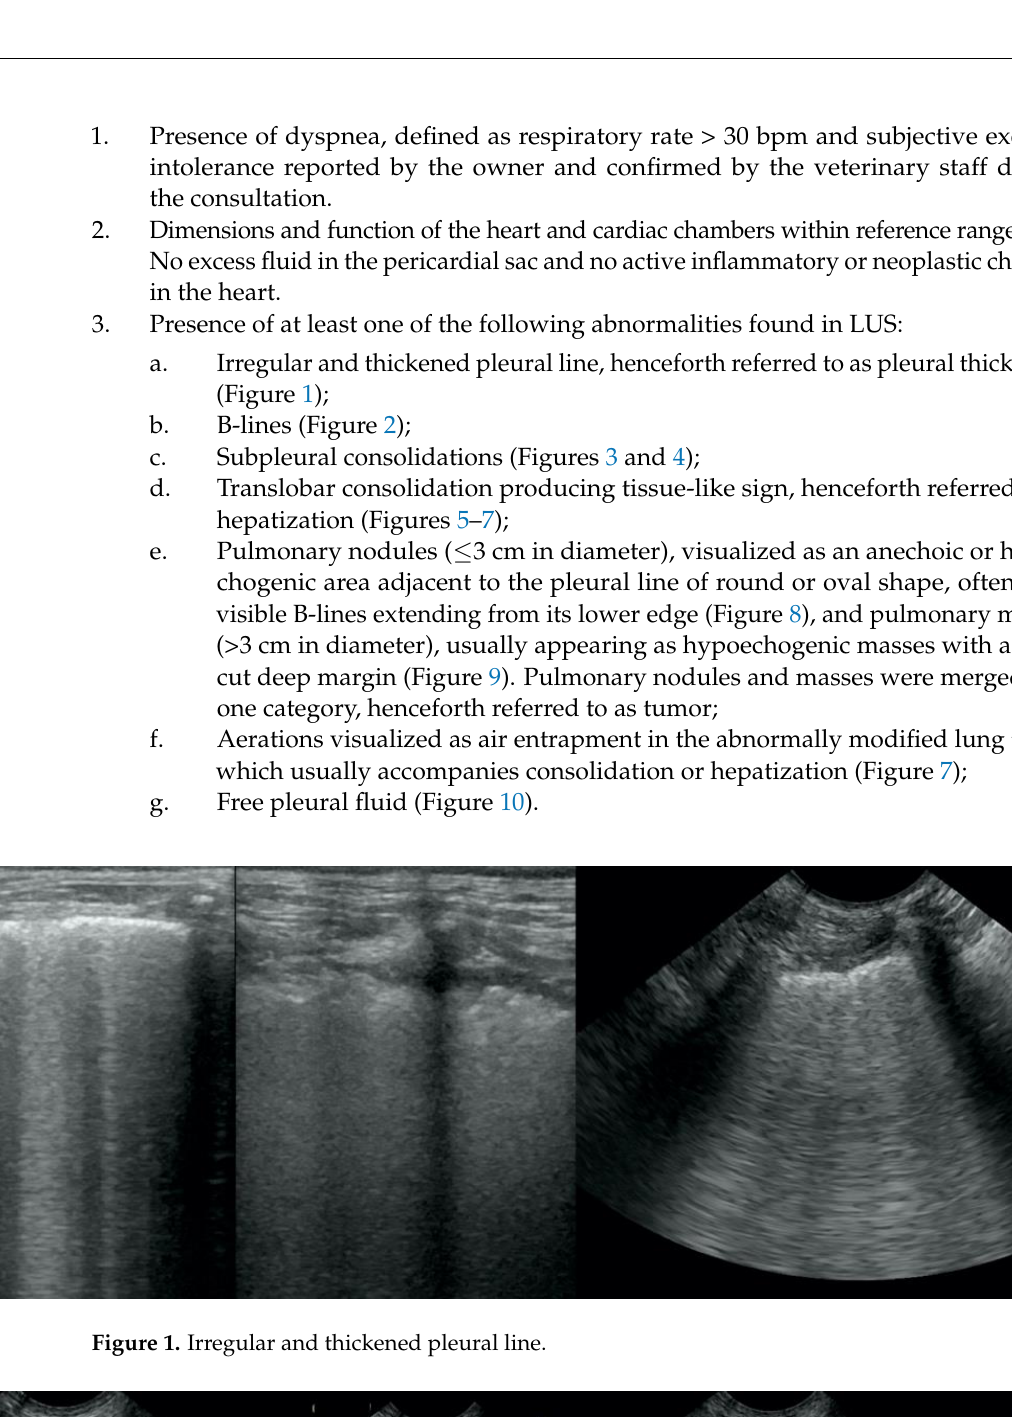
Animals 2022 , 12 , x